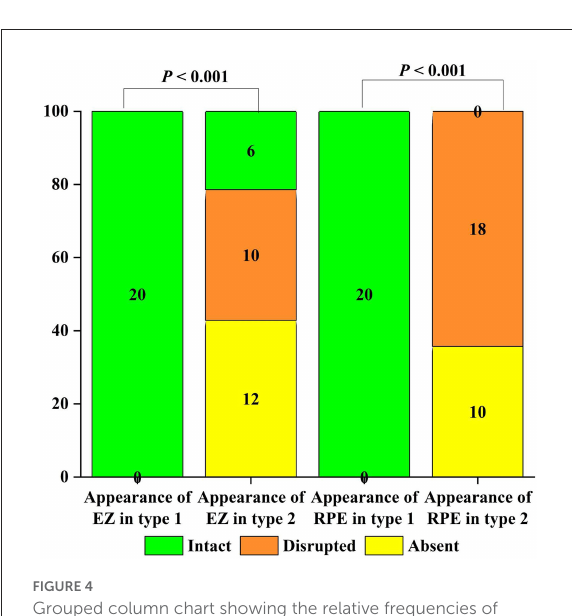
FIGURE4 Grouped column chart showing the relative frequencies of optical coherence tomography (OCT) qualitative findings in the study cohort. The chart shows the relative frequencies of eyes graded with a specific OCT finding. The relative frequencies are given as a percentage of patients with a specific characteristic in a distinct group. The numbers in the graph represent the value of each